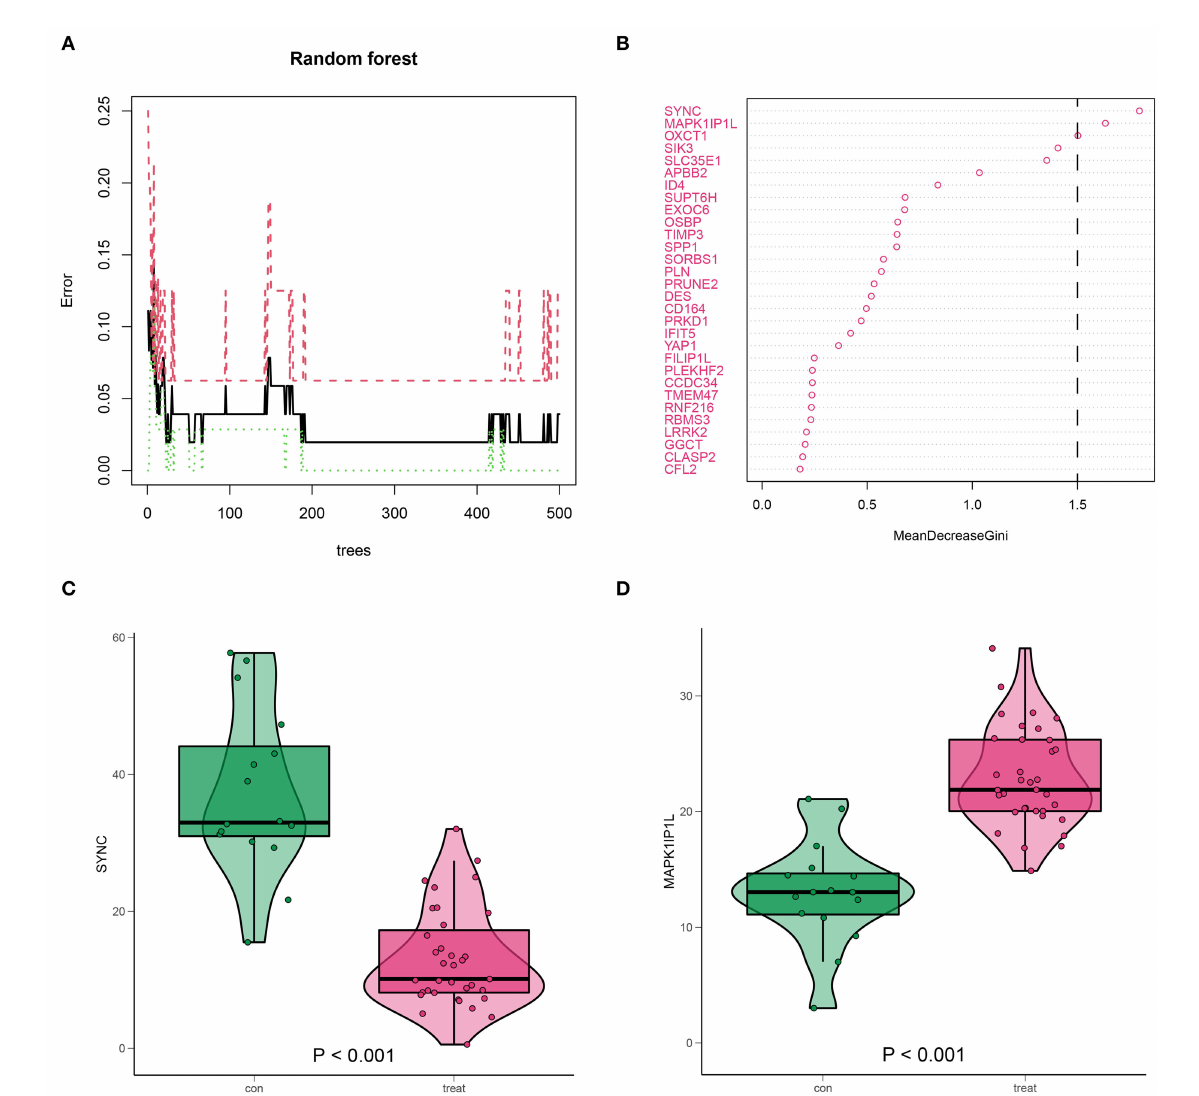
FIGURE9 Identification for high m6A AD-associated key genes by random forest (RF). (A) RF screening for 657 DEGs. (B) SYNC and MAPK1IP1L (mean decrease Gini score > 1.5) scored top in the gene importance score list. (C,D) The expression level of SYNC and MAPK1IP1L in AD samples.